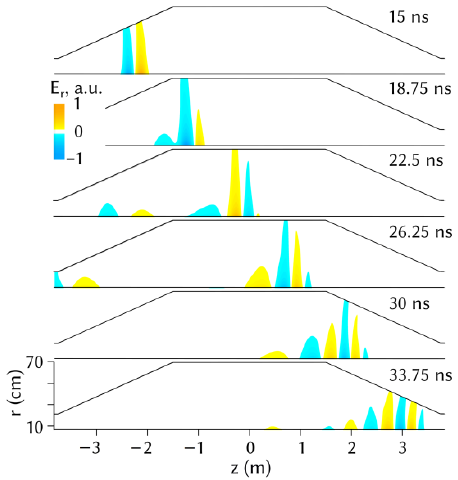
Figure 8. Calculated structure of the electric field in the line ( E r component) with uniform plasma filling of the central section (electron density n e = 7.7 × 10 8 cm −3 ) at six sequential time instants.